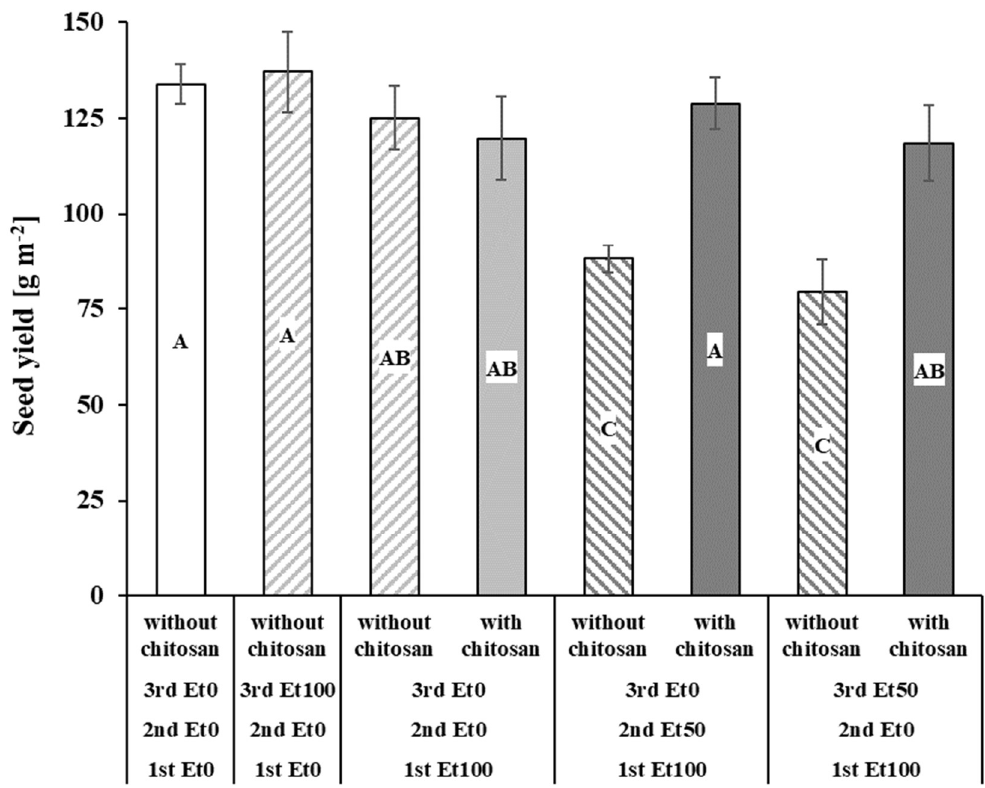
Figure 2. Role of the Ethylene [Et] application at full dose [100%, indicated as Et100] or half dose [50%], indicated as Et50 or no application [0%, indicated as Et0] during the first, second and third (1st, 2nd, and 3rd, respectively) occasion as shown in Figure 1) and chitosan application on the Seed yield of onion growing under rainfed conditions. Moment of ethylene application included an early, mid, and late applications indicated as first, second and third (1st, 2nd, and 3rd, respectively) occasions in the figures. Amount of ethylene application included 100% recommended rate (in the 1st or 3rd occasions) or 100% in the 1st + 50% in either the 2nd or 3rd occasions. Chitosan application was performed in “Treat” including a 100% application in the 1st occasion (irrespective of the further 50% application in the 2nd or 3rd occasions) compared to a non-chitosan treatment. A control with no chitosan and no ethylene was included. When Chit(Treat) showed a p < 0.05, p-differences of the LSmeans were computed and separated by a conservative Tukey − Kramer grouping at the 5%. Bars with a letter in common should not be considered different according to Tukey − Kramer. Data are arithmetic means and standard errors ( n = 4).